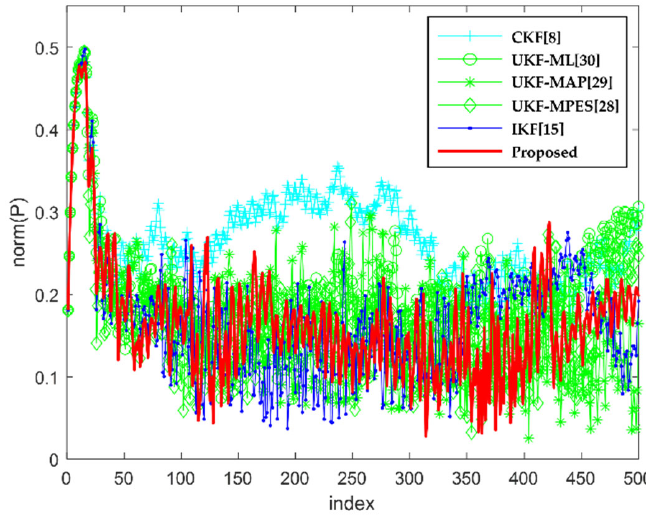
Figure 5. The matrix norm of error covariance matrix according to each filter. Table 3. Comparison results of the filter performance.